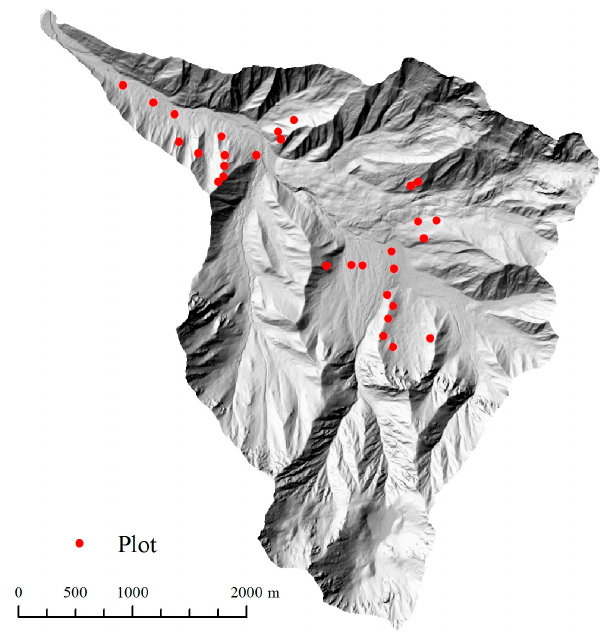
Figure 3. Distribution of plots in Tianlaochi catchment, Gansu Province, China.